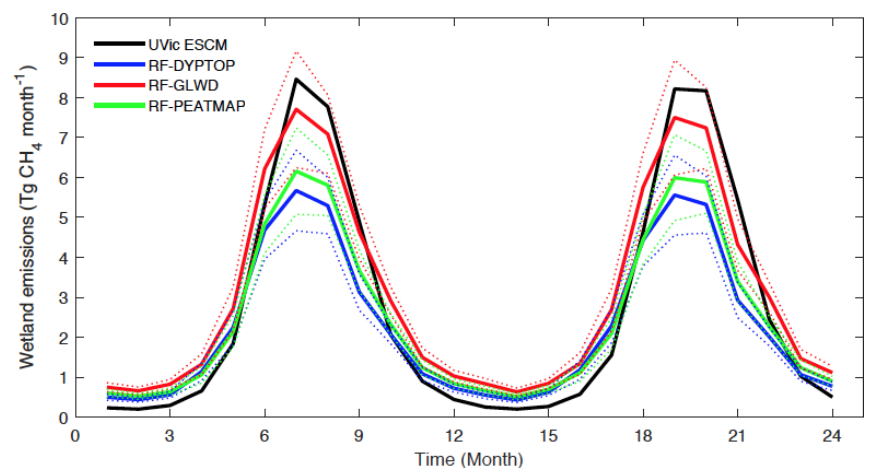
Figure 9. Seasonal variations of CH 4 emissions from wetlands north of 45 ◦ N over the 2013–2014 period as simulated by the UVic ESCM in comparison to three upscaled flux measurements (RF-DYPTOP, RF-GLWD, and RF-PEATMAP). The dashed lines show the uncertainty range for the upscaled flux measurements.